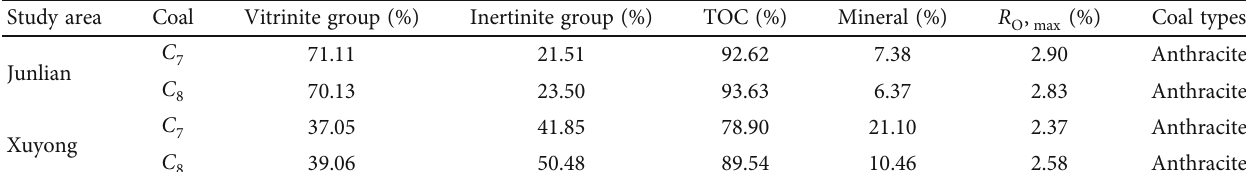
Table 3: Coal maceral composition and coal quality characteristics in southern Sichuan.